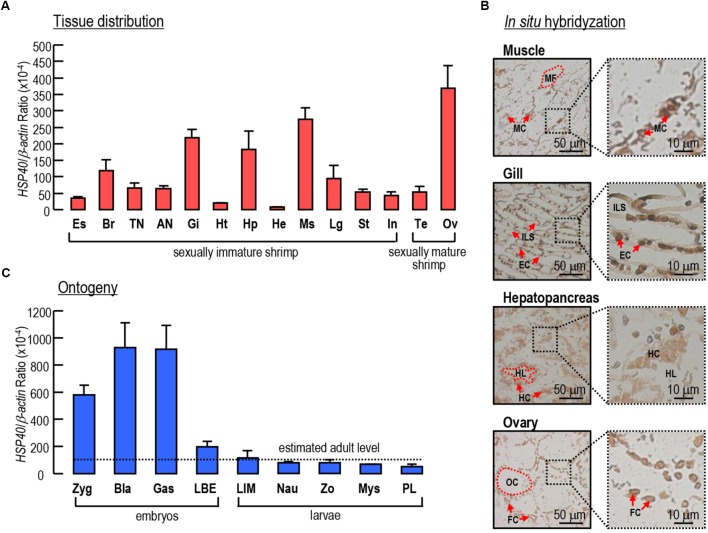
(A) Tissue distribution of Lv-HSP40 mRNA. The selected tissues include eyestalk (Es), brain (Br), thoracic nerve (TN), abdominal nerve (AN), gill (Gi), heart (Ht), hepatopancreas (Hp), hemolymph (He), muscle (Ms), leg (Lg), stomach (St), intestine (In), testis (Te), and ovary (Ov). (B)
In situ hybridization of Lv-HSP40 mRNA expression cells in the muscle, gill, hepatopancreas and ovary. The cell types and tissue structures in ISH include myocytes (MC), myofibril (MS), epithelial cells (EC), inter lamellar space (ILS), hepatopancreatic cells (HC), tubule lumen (TL), oocytes (OC), and follicle cells (FC). The scale bars for the overall and partial pictures were 50 μm and 10 μm, respectively. (C) Ontogeny of Lv-HSP40 mRNA. The selected embryonic and larval developmental stages include the zygote (Zyg), blastula (Bla), gastrula (Gas), limb bud embryo (LBE), larva in membrane (LIM), nauplius (Nau), zoea (Zo), mysis (Mys) and post-larval (PL) stages. For tissue distribution and ontogeny, the data presented are expressed as the mean ± S.E. (n = 6).